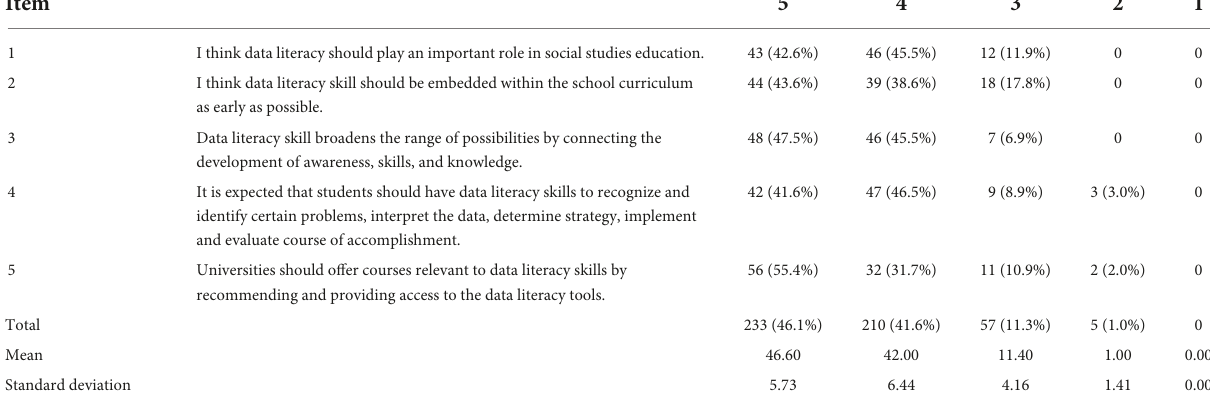
TABLE 1 Data literacy skill.